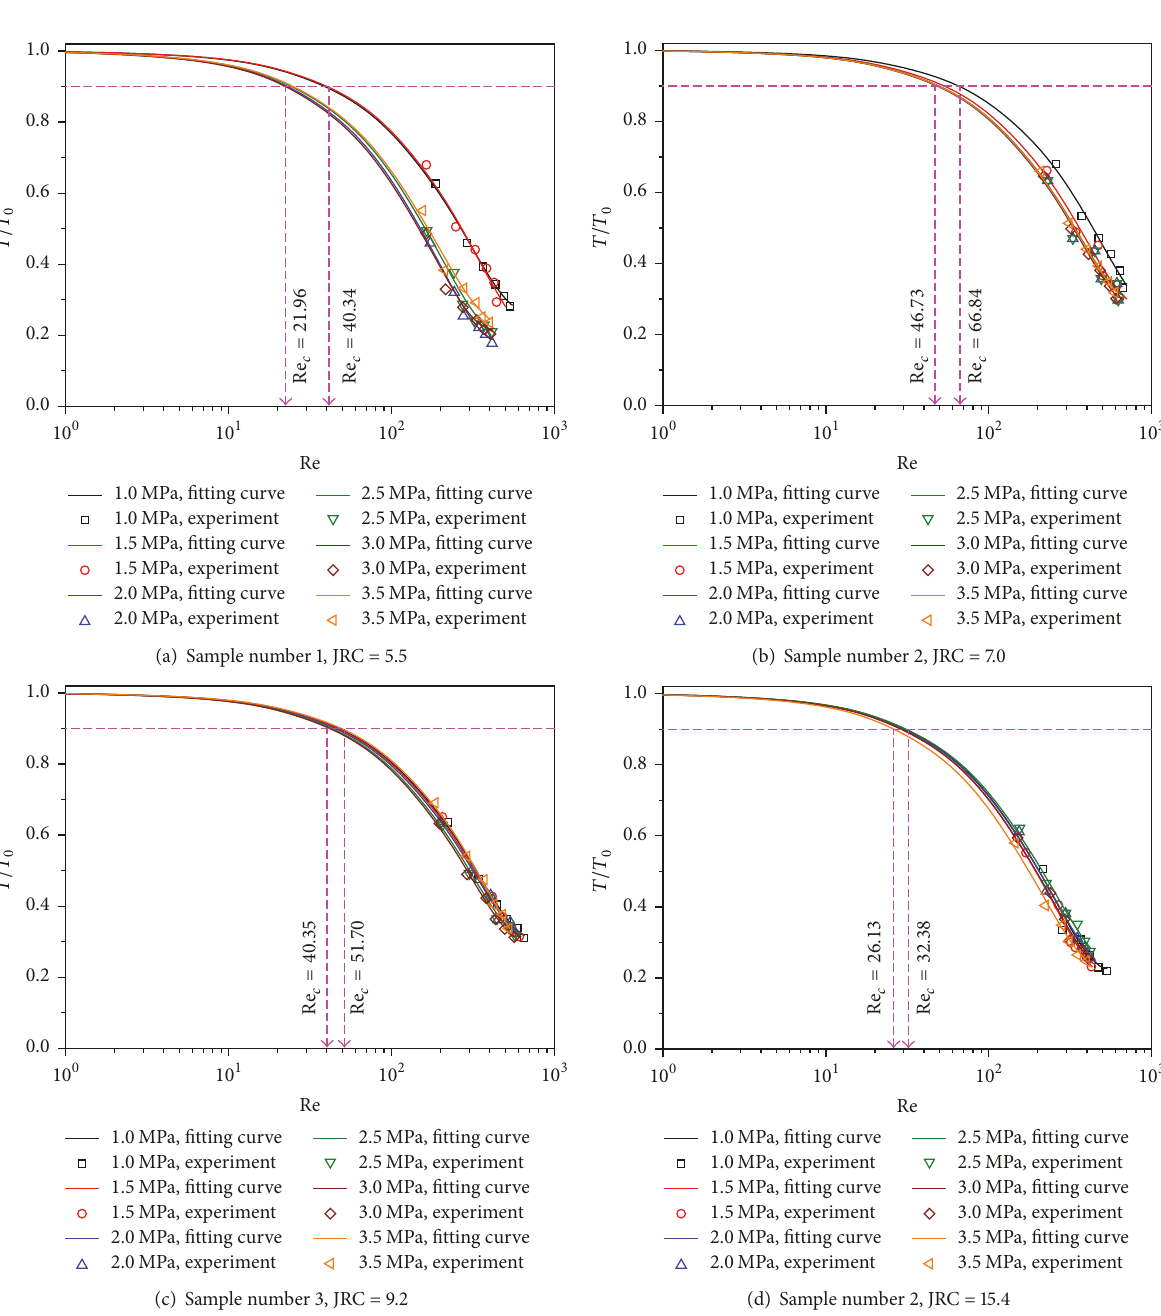
compression will increase Re 𝑐 [36]. When continuously increasing confining pressure, the contacts between two frac- ture walls are destroyed and the microfractures may propa- gate within rocks and the split rock fragments will be clamped by the two walls, which gives rise to complex flow behaviors and decreases Re 𝑐 . For the sample G1, with increasing con- fining pressure, Re 𝑐 steadily decreases and shows a different variation trend with other samples. They reported that Re 𝑐 for the samples G1 ∼ G4 and S1 ∼ S2 varies in the ranges 0.075 ∼ 9.243, 0.120 ∼ 4.467, 0.160 ∼ 5.108, 0.039 ∼ 4.509, 0.191 ∼ 4.090,